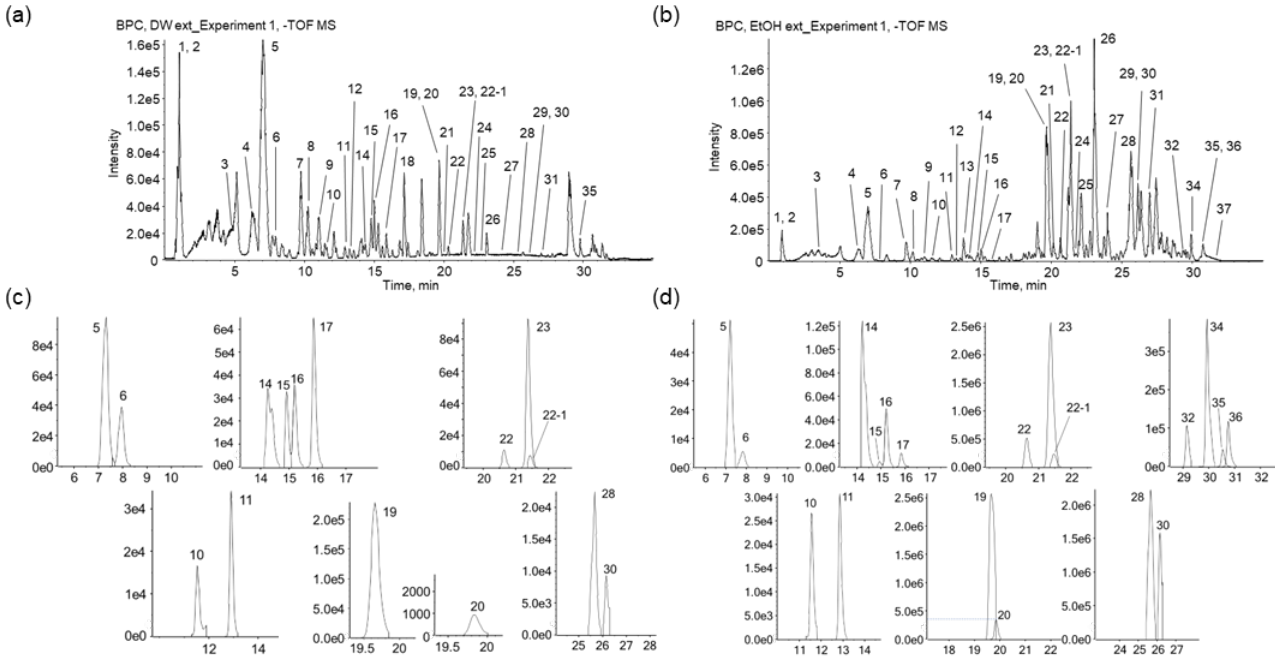
7 of 19 Figure 5 . Effects of PSY on the STAT3 signaling pathway in human CRC cells. Whole lysates of CRC cells treated with PSY EtOH-Ex for 24 h were subjected to Western blot analysis for JAK2, p-JAK2, Src, and p-Src ( a ), and SHP1 and SHP2 ( b ). In addition, lysates of HCT116 cells treated with pervan- adate (5 µM) and PSY (50 µg/mL) for 24 h were subjected to Western blot analysis for STAT3 and p- STAT3 ( c ). β -actin was used as an internal control. Data in graphs present the mean ± SD to that of the untreated cells taken as 1 (*, p < 0.05 and **, p < 0.01 versus control). 2.4. Chemical Identification in PSY Extracts